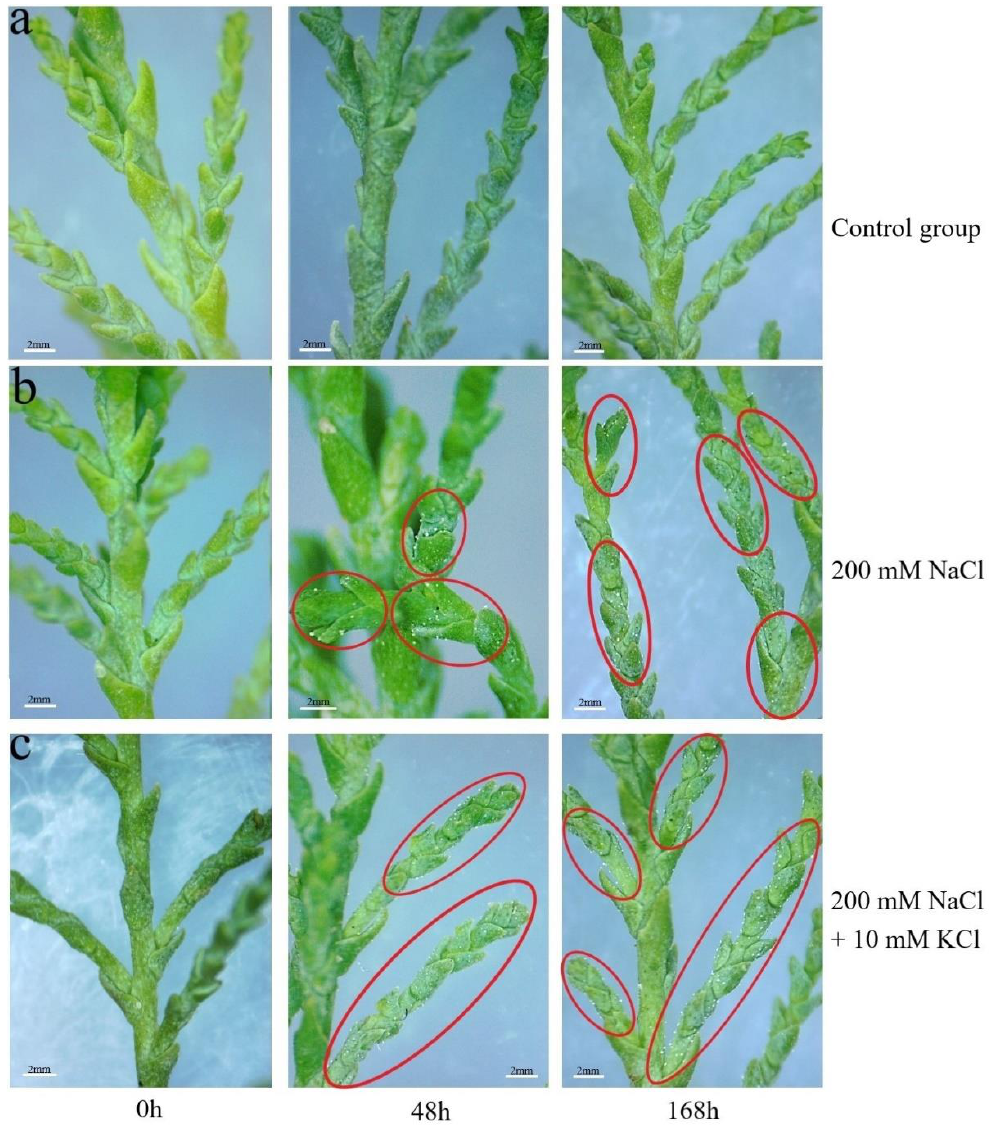
Figure 1. Changes in salt secretion in leaves of T . ramosissima under different treatments. Changes of salt secretion in leaves of T . ramosissima at 0 h, 48 h and 168 h under different treatments. Note: ( a ) represents the control group, ( b ) represents 200 mM NaCl, and ( c ) represents 200 mM NaCl + 10 mM KCl. The red circled parts indicate the salt secretion distribution of T . ramosissima leaves under different treatments. ( a ) and ( b ) refer to the data of Chen et al. (https://doi.org/10.1371/jour- nal.pone.0265653).